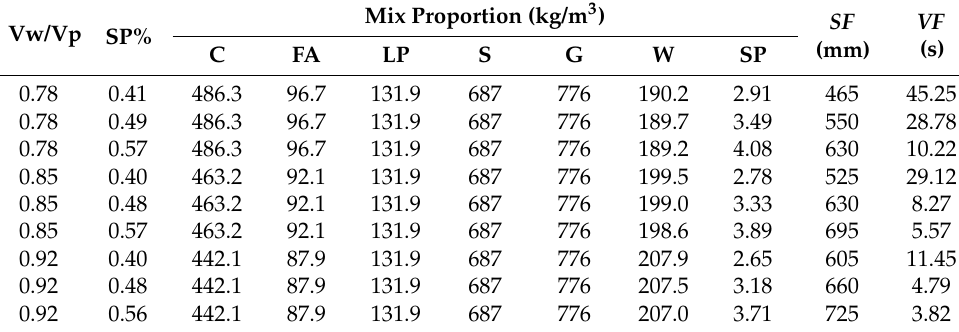
Table 13. Mix proportions and test results of SCC in series 5.